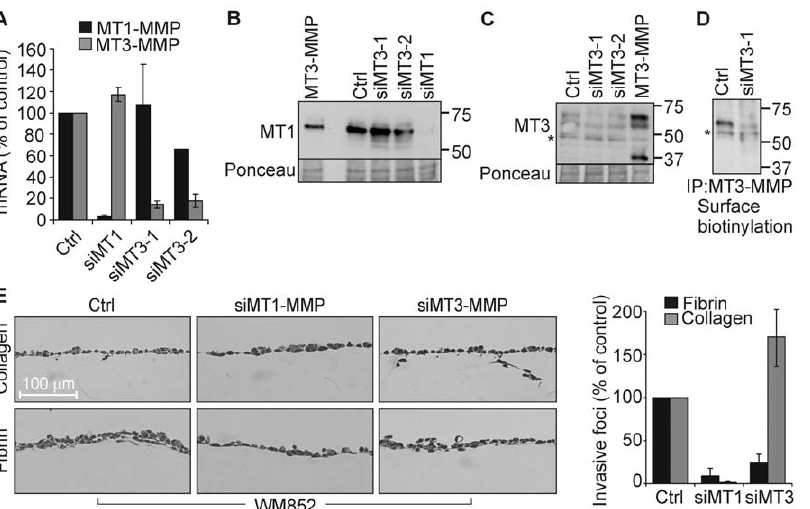
Figure 3. MT3-MMP silencing inhibits fibrin invasion and enhances collagen invasion of WM852 cells. (A) MT1-MMP and MT3-MMP mRNA expression in WM852 cells transfected with control siRNA (Ctrl) or siRNAs targeting MT1-MMP (siMT1) or MT3-MMP (siMT3-1 and siMT3-2) were quantified by qPCR (n=3). (B and C) The protein levels of MT1-MMP (B) and MT3-MMP (C) were assessed by immunoblotting after transient transfection of the siRNAs or MT3-MMP cDNA (MT3-MMP) as indicated. MT1-MMP was detected as a 60 kDa band and MT3-MMP as 65/60 kDa bands that were downregulated by the corresponding siRNAs. An additional MT3-MMP fragment of 37 kDa in size was detected in the cells after transient transfection with MT3-MMP cDNA. Ponceau-staining served as a loading control. Asterix marks a non-specific band. (D) Cell surface MT3-MMP was detected by surface biotinylation of cells transfected with control siRNA or the most efficient MT3-MMP siRNA (siMT3-1), followed by immunoprecipitation. Asterix marks a non-specific band. (E) Light micrographs of fibrin and collagen cross-sections visualize the invasion of WM852 cells transfected with the indicated siRNAs. The cells were plated atop 3D fibrin and type I collagen 1 d after siRNA transfections and allowed to invade for 5 d. Quantitative results are expressed as the number of invasive foci per microscopic field